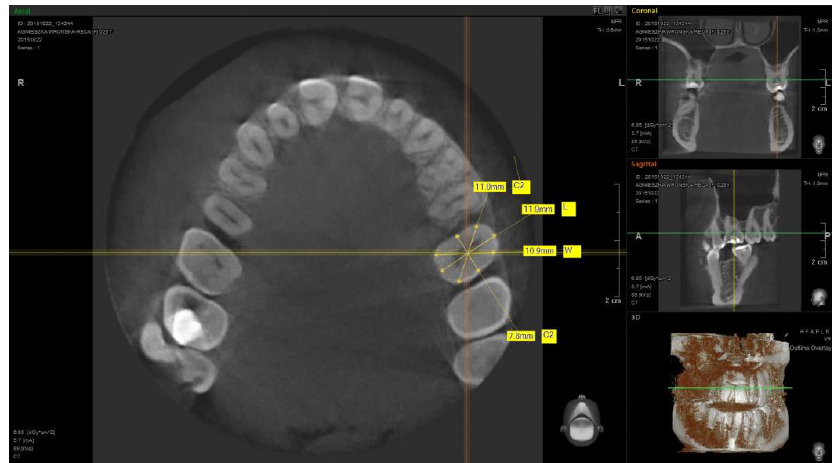
Figure 2. Example of a measurement of the first molar cross-section.